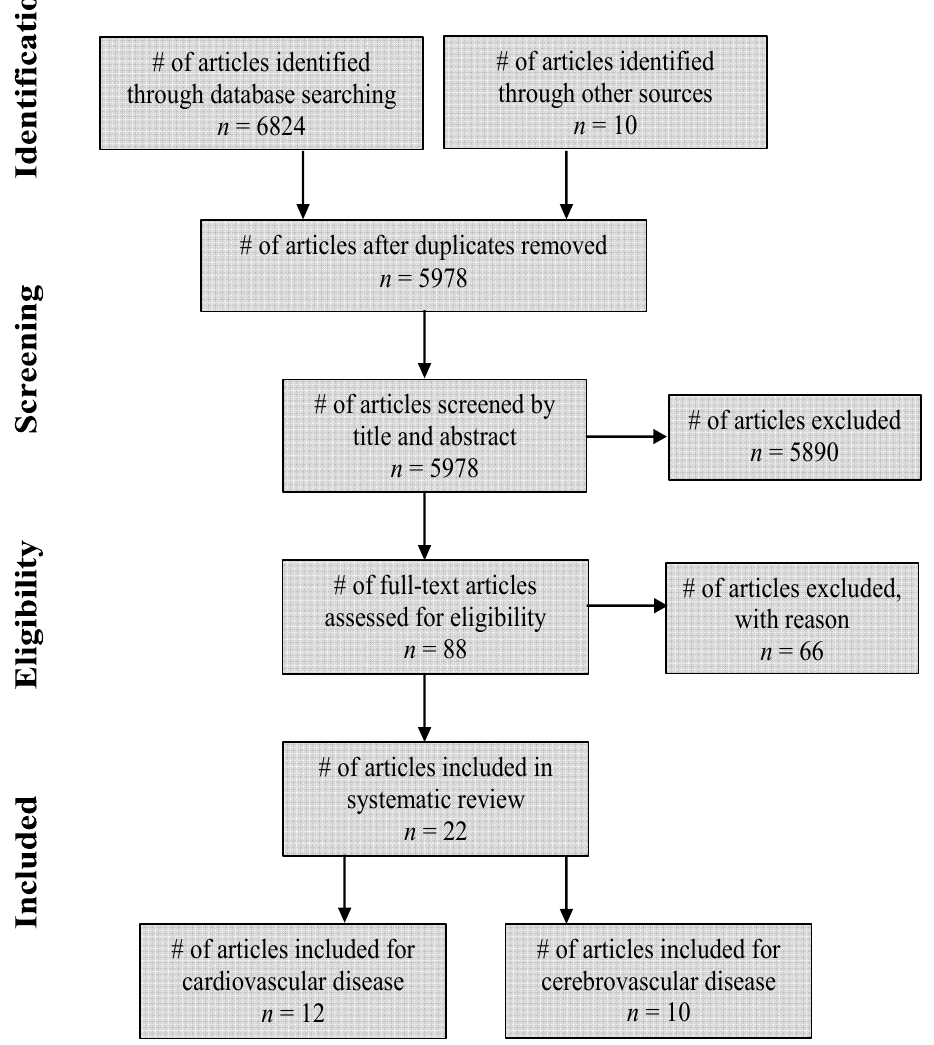
Figure 1. Search process and results.